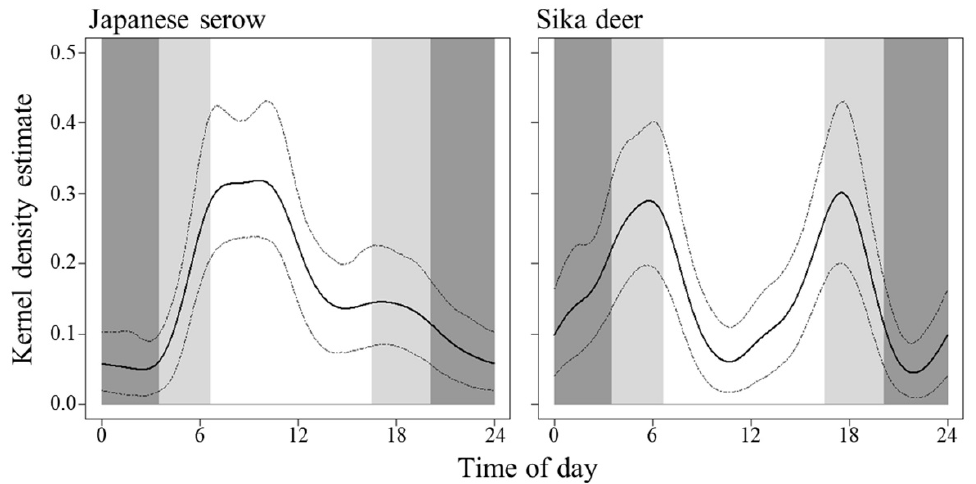
Figure 4. Circular kernel density models showing the overall daily activity patterns of Japanese serow and sika deer in Tsumagoi, central Honshu, Japan. Dashed lines indicate the 95 % confidence intervals. The dark gray-shaded, light gray-shaded, and white areas indicate nighttime, dawn and dusk, and daytime, respectively. The day division was according to Ikeda et al. [52]: dawn (1 h before and after sunrise), dusk (1 h before and after sunset), daytime (from 1 h after sunrise to 1 h before sunset), and nighttime (from 1 h after sunset to 1 h before sunrise). Data on the time of sunrise and sunset in Maebashi (36°23′ N, 139°4′ E), recorded by the National Astronomical Observatory of Japan, were used.